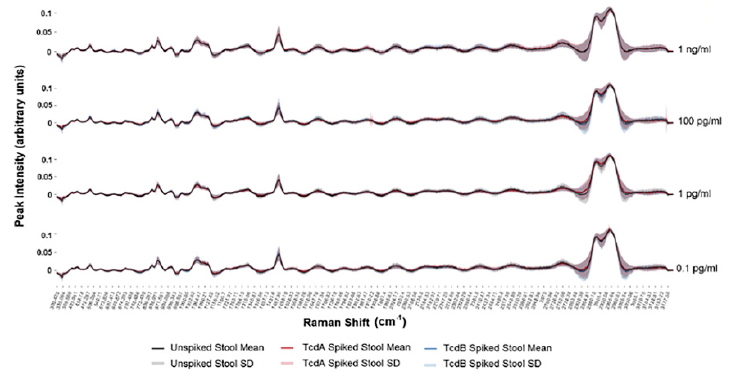
Figure 7. Mean Raman Spectra: Mean Raman spectra for unspiked stool, TcdA-spiked stool and TcdB-spiked stool with respective standard deviation for 1 ng / mL (top), 100 pg / mL (second from top), 1 pg / mL (third from top) and 0.1 pg / mL (bottom) were plotted on x -axis for Raman shift 300–3200 / cm and their intensities in arbitrary units on y -axis [119].